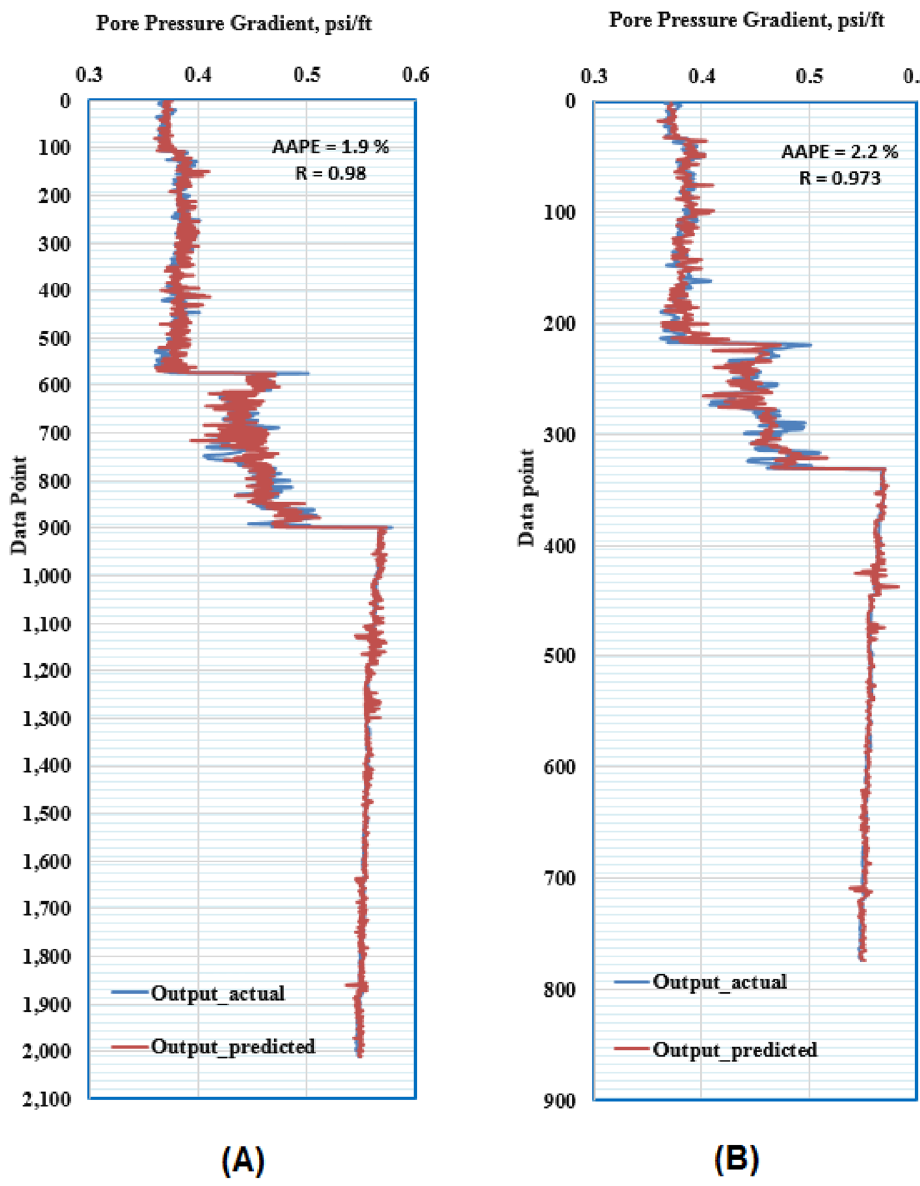
Figure 8. Formation pressure gradient profiles ( A ) training, and ( B ) testing (ANN model).